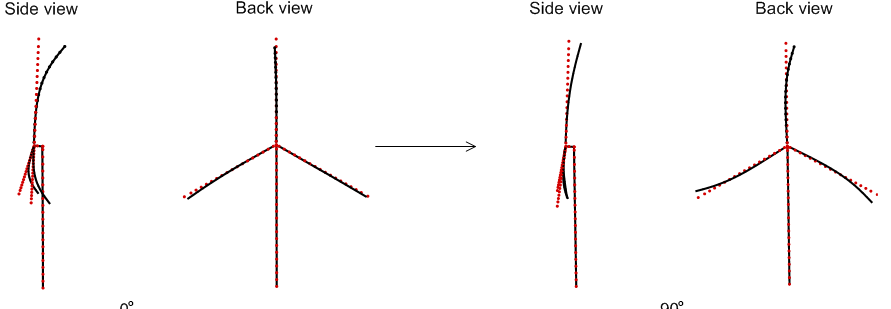
Figure 3. Mode shape alternation from 0 to 90 ◦ pitch for symmetric out-of-plane mode M5. The red symbols indicate an undeformed state, and the black lines indicate a deformed state.